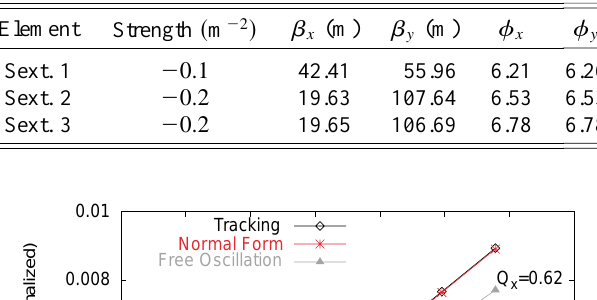
TABLE I. Strength of the sextupoles and Twiss functions at their locations used in the simulation. Element